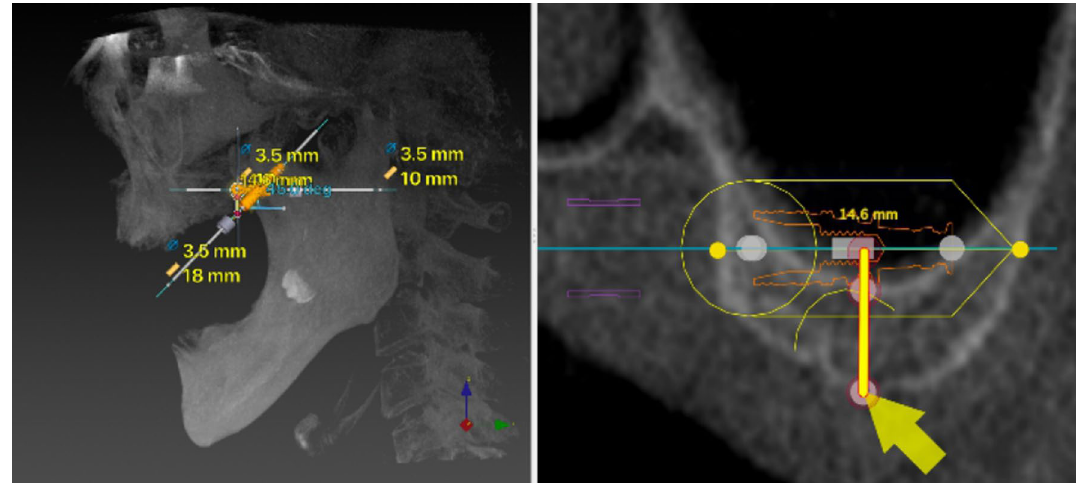
Fig. 5 The interface of the software was adjusted to the coronal plane until the central part of the second virtually placed implant was observed. The midpoint of the alveolar ridge was confirmed as the entrance point of the pterygoid